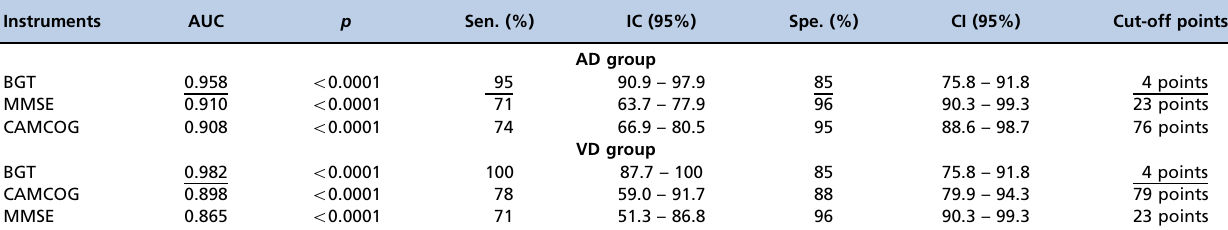
Table 2 - Sensitivity and specificity data according to the ROC curve methodology, in AD and VD groups. Sen.=sensitivity; Spe.=Specificity; AUC=area under the curve; CI=confidence interval. p = x 2 . Instruments